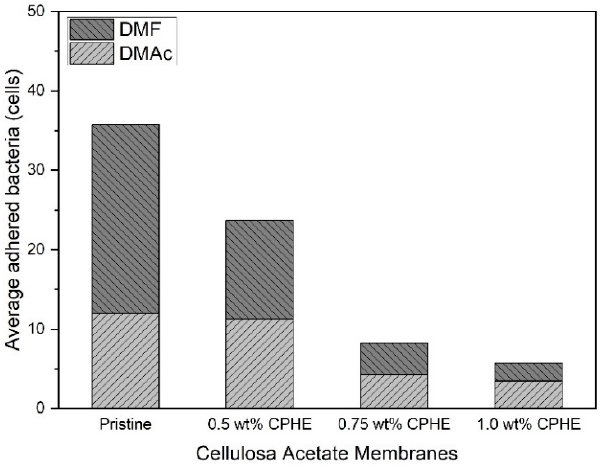
Figure 10 . Number of bacteria attached to the membrane. Figure 10. Number of bacteria attached to the